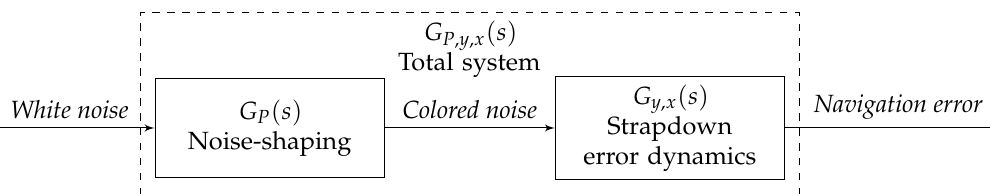
quantization noise. Figure 2. Power spectral density of the north position error from different inertial sensor noise processes.